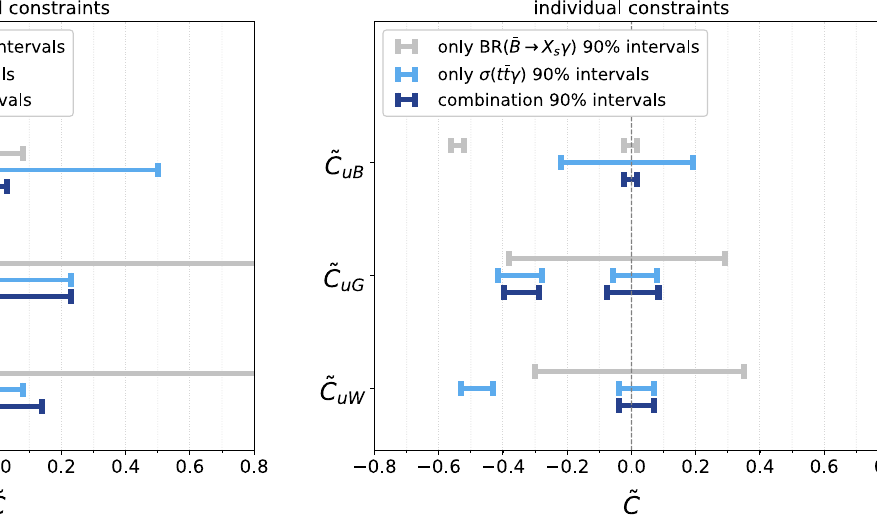
Fig. 11 Comparison of the smallest intervals containing 90% proba- bilityofthe1Dmarginalizedposteriordistributionforthefitsusingonly BR( ¯ B → X s γ ), only σ( t ¯ t γ) and using their combination. Shown are the intervals for (left) the 1D marginalized posterior distributions for